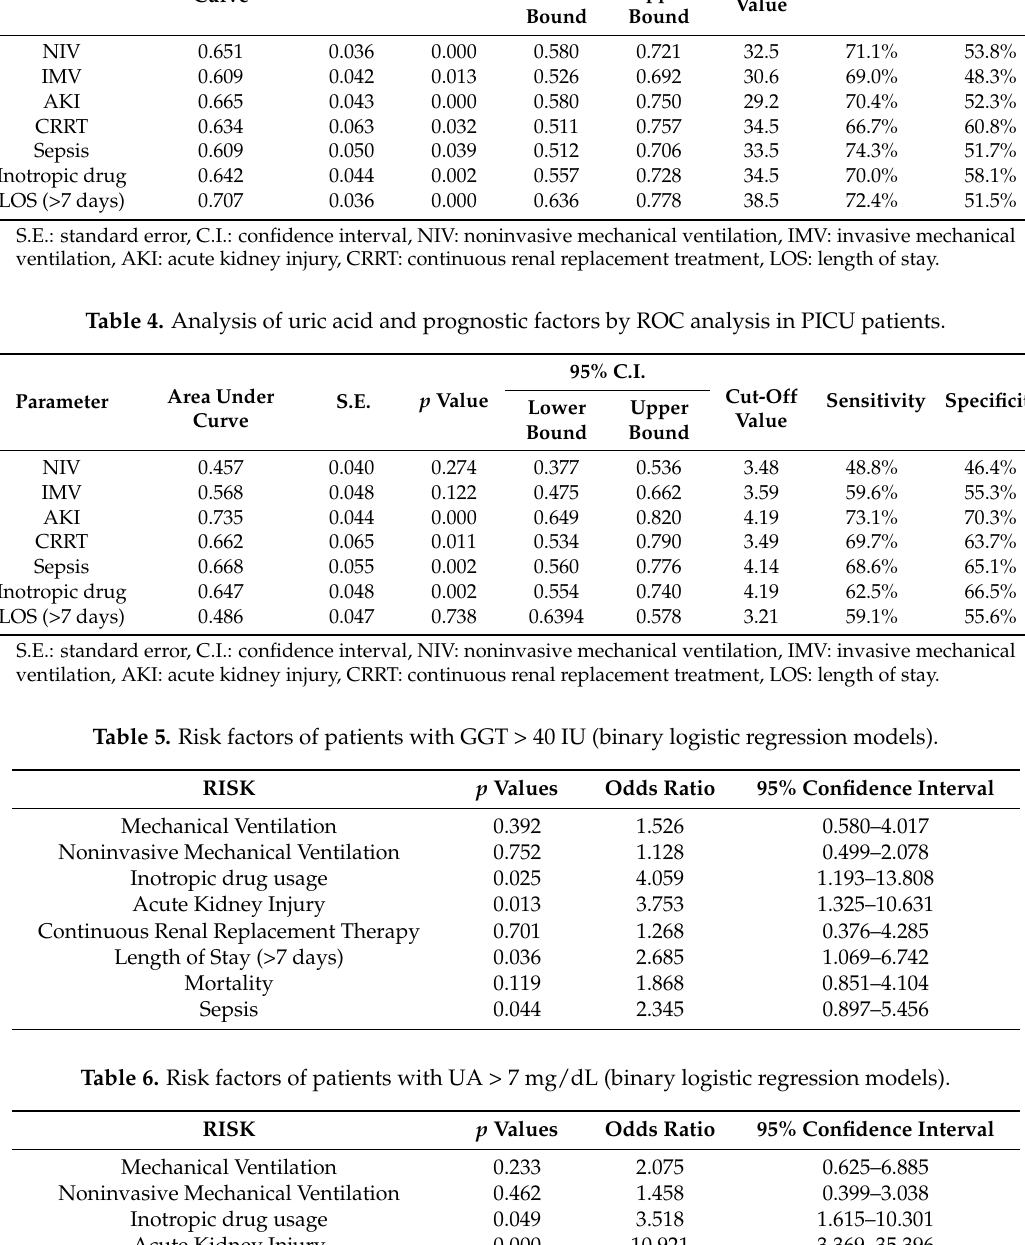
Table 3. Analysis of gamma glutamyl transferase (GGT) and prognostic factors by receiver operating characteristic (ROC) analysis in PICU patients.